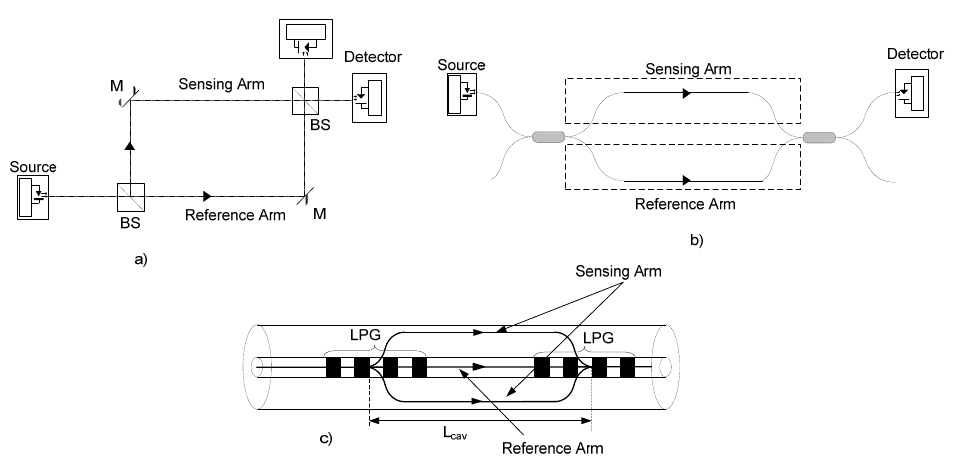
Figure 3. Mach–Zehnder interferometric configuration: ( a ) bulk; ( b ) optical fiber interferometer; ( c ) in-fiber LPG interferometer.